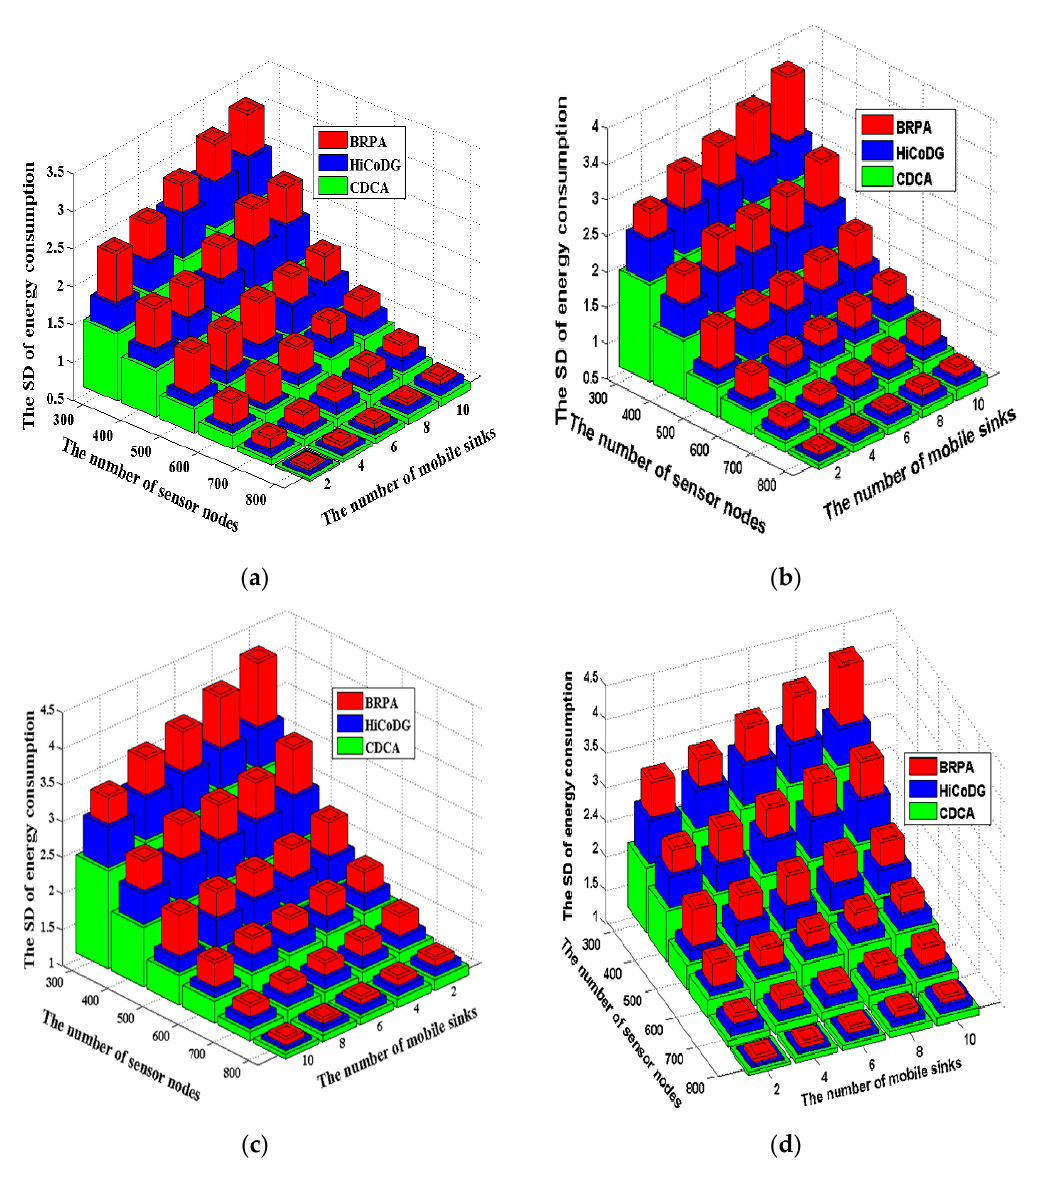
Figure 7. The comparison of SD energy consumption of three algorithms. ( a ) BD-Scenario; ( b ) UD1-Scenario; ( c ) UD2-Scenario; ( d )